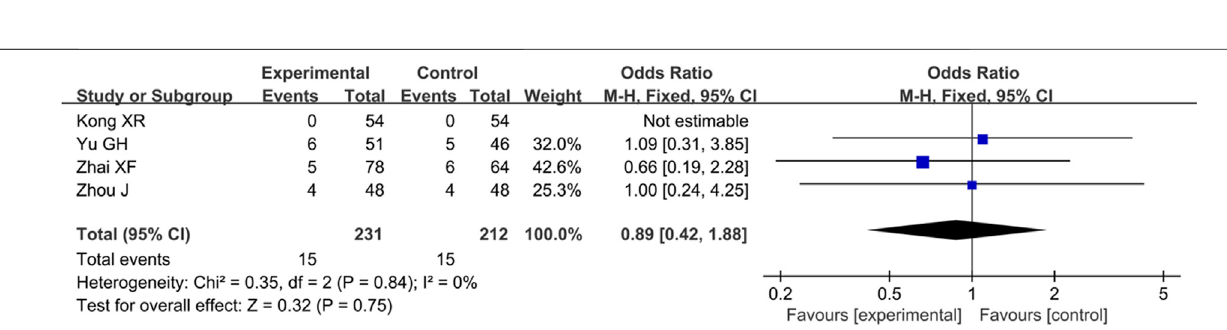
FIGURE 8 | Forest plot of meta-analysis of add-on effects of ginkgo diterpene lactone meglumine injection on ADRs/ADEs; ADRs/ADEs, adverse drug reactions/ adverse drug events.